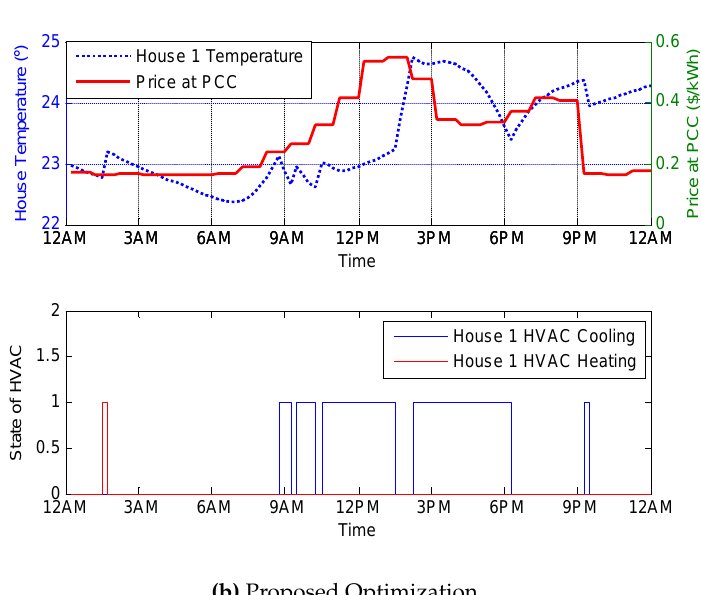
Figure 5. House temperature and HVAC status in grid-connected mode. ( a ) Autonomous temperature control by traditional thermostats in grid-connected mode; ( b ) Intelligent control by proposed optimization in grid-connected